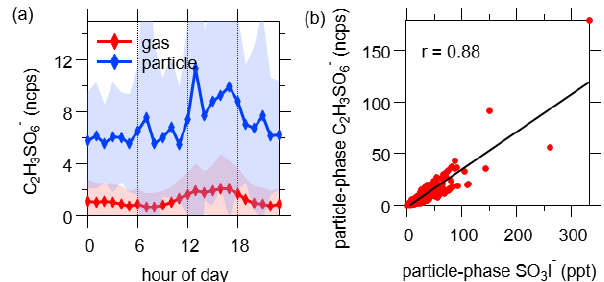
Figure 9. (a) Diurnal variation of C 2 H 3 SO − dicate 1 standard deviation. (b) Correlation between particle-phase C 2 H 3 SO − and SO 3 I − 6